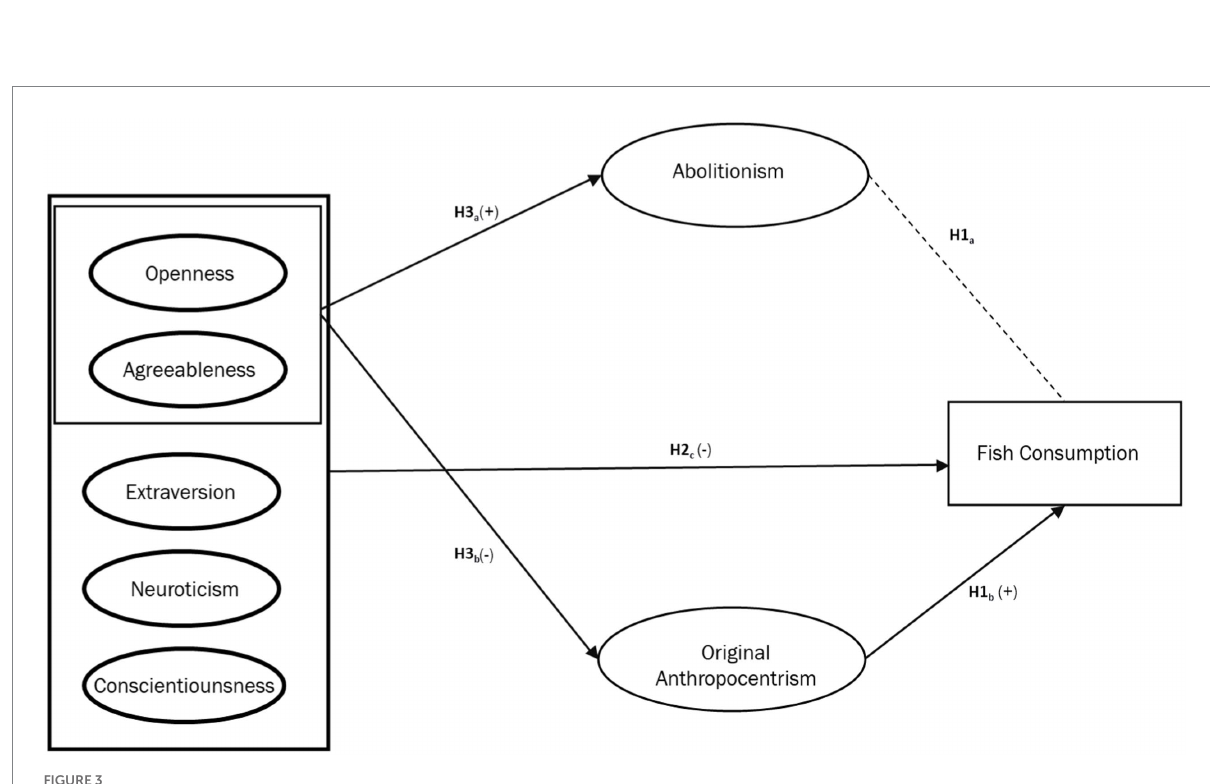
FIGURE 3 Conceptual model depicting the hypothesized relationships between the big five personality traits. Abolitionist ethical concern, and frequency of fish